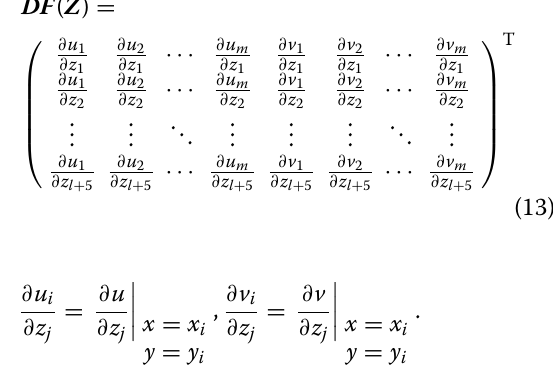
ment filed. b) Using ( x o , y o ) as the center, select a fitting area radius r . Take the fitting point in the displacement filed after removing the plastic